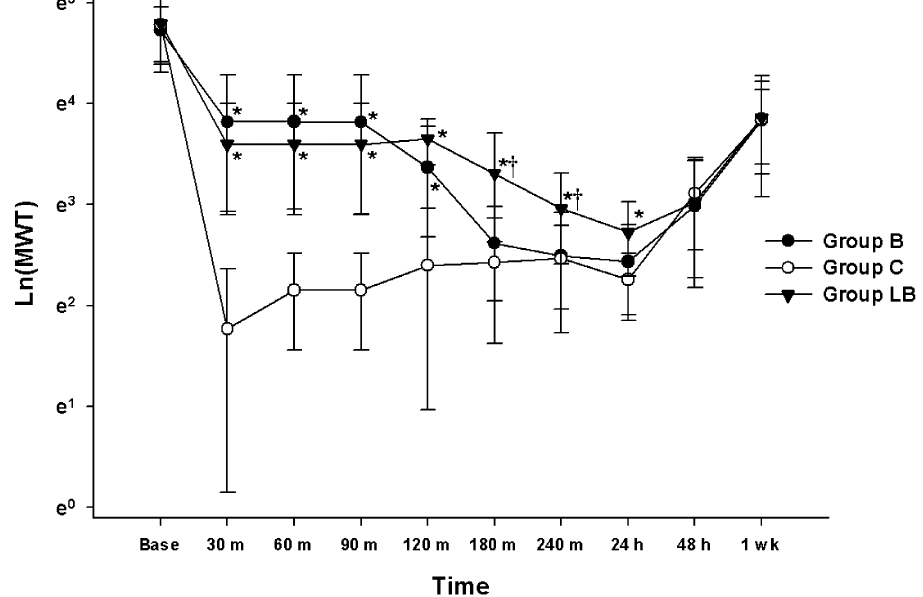
Figure 2. Evaluation of analgesic effects of bupivacaine and liposomal bupivacaine. The graphs are presented as mean ± standard deviation of the mechanical withdrawal threshold with von Frey filaments. Group B: received intra-plantar bupivacaine, Group C: received intra-plantar normal saline, Group LB: received intra-plantar liposomal bupivacaine, Base: baseline, MWT: mechanical withdrawal threshold. * P < 0.05 compared with the control group, † P < 0.05 compared with the bupivacaine